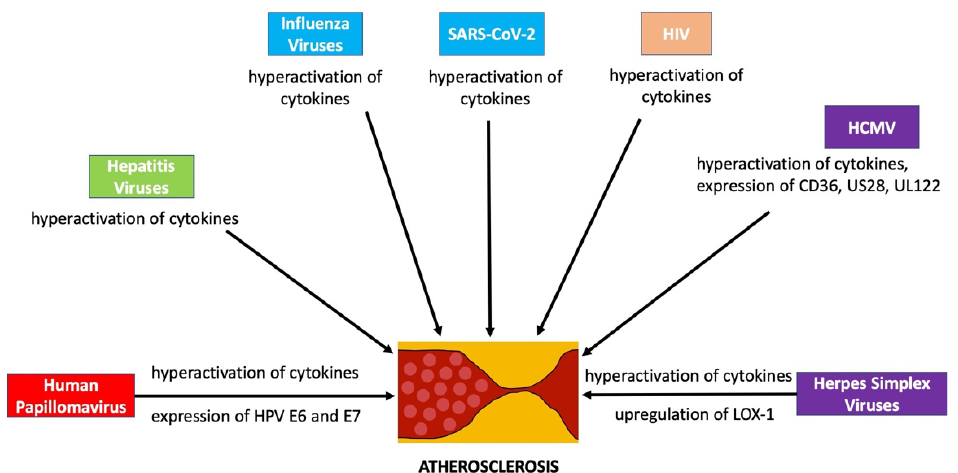
Figure 1. The Currently Defined Mechanisms of Atherosclerosis Development by virus infection. All viruses can induce the hyperactivation of cytokines and activate immune cells in a host, while some viruses exhibit additional unique mechanisms in the development of atherosclerosis. SARS CoV-2, severe acute respiratory syndrome coronavirus-2; HIV, human immunodeficiency virus; HCMV, human cytomegalovirus; HPV, Human Papilomavirus; LOX, lectin-like oxidized LDL receptor.